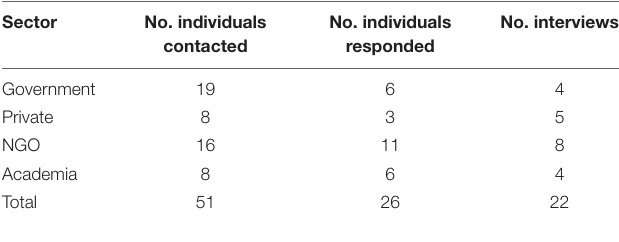
TABLE 1 | Overview of individuals contacted and interviewed by